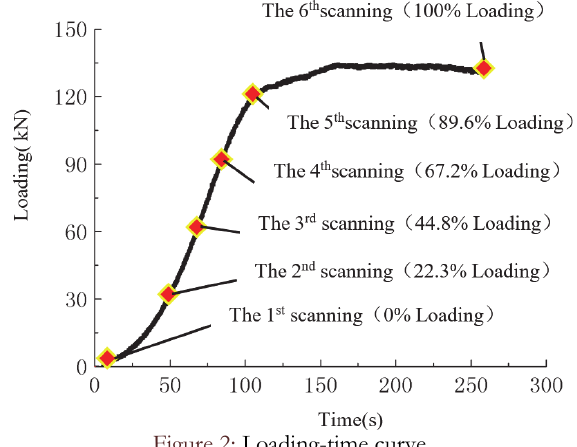
Figure 2: Loading-time